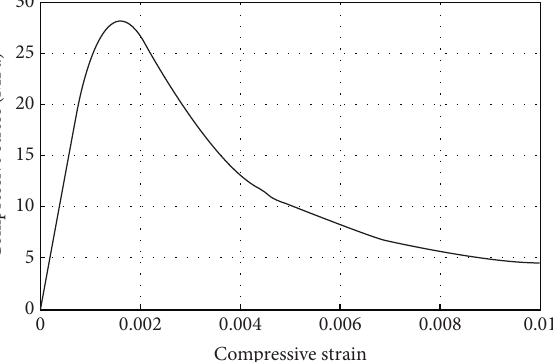
Figure 10: Tensile stress-strain curve of